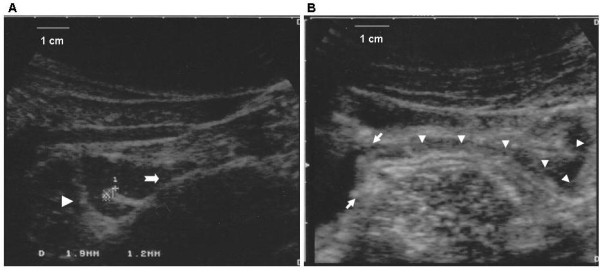
A. SICUS assessment of ileo-colonic anastomosis. Calipers indicate thickness of ileal (up) (1.9 mm) and colonic (down) (1.2 mm) limbs. Arrowhead indicates colon, arrow indicates neo-terminal ileum. B. SICUS assessment of ileo-colonic anastomosis and neo-terminal ileum. CD intramural involvement of ileo-colonic anastomosis (thickness 10 mm see arrows) and neo-terminal ileum (extending for 8 cm, see arrowhead).